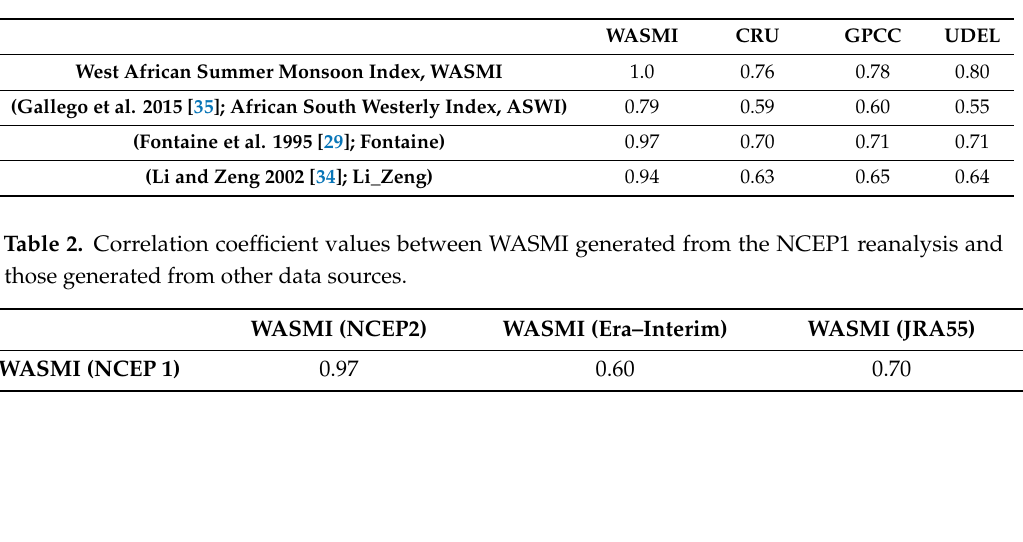
Figure 9. Spatial correlation between WASMI and JJAS rainfall of ( a ) CRU, ( b ) GPCC, and ( c ) UDEL. Stippling indicates regions where changes are significant at the 95% level. Table 1. Correlation coe ffi cient values between various indices and rainfall datasets.